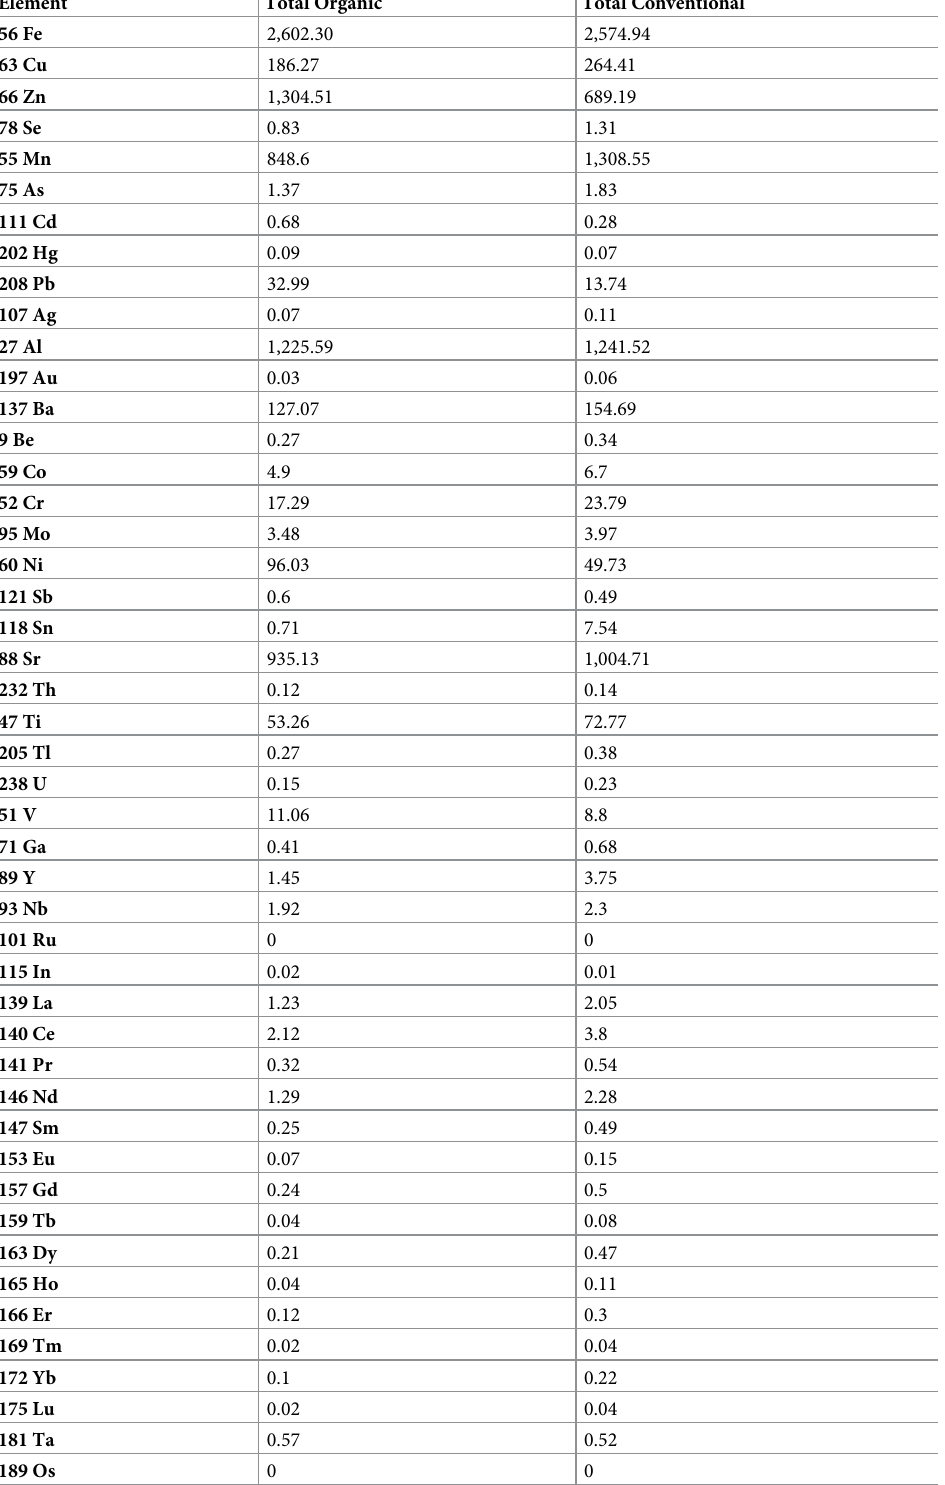
Table 2. Concentration of each element in all organic and conventional